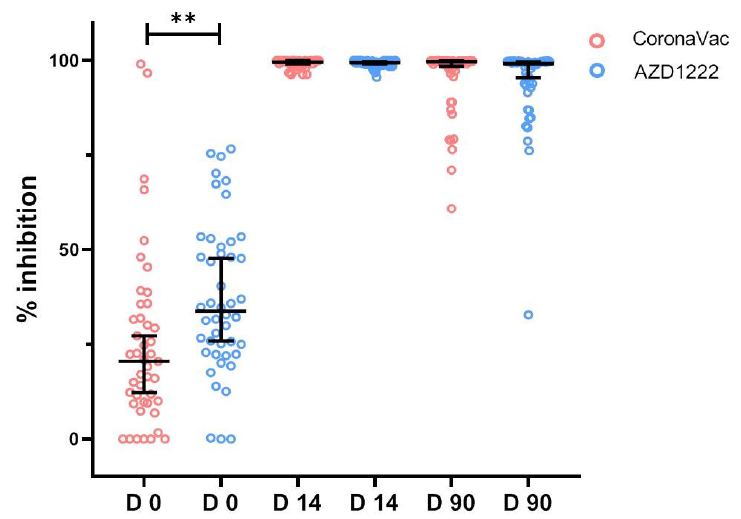
Figure 3. Surrogate virus neutralization test to Delta variants before, and D14 and D90.after booster vaccination with mRNA-1273 in participants who received two doses of CoronaVac and two doses of AZD1222. ** represented p value < 0.01